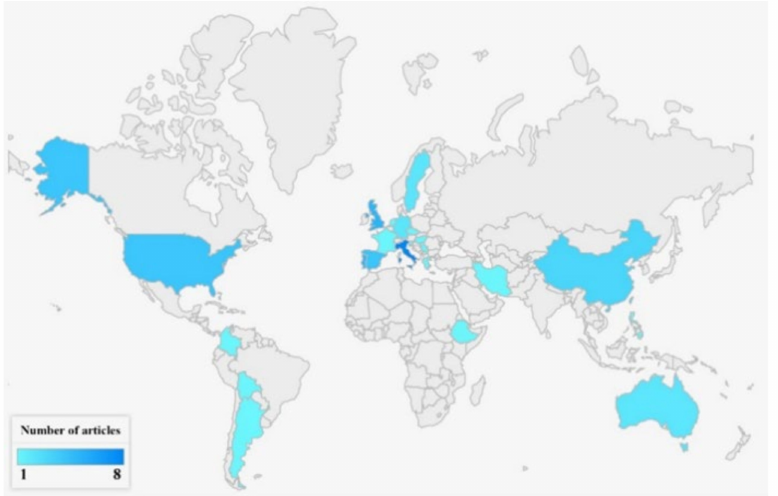
Figure 5. Geographical distribution of UF-NBS research countries (based on the case study location).